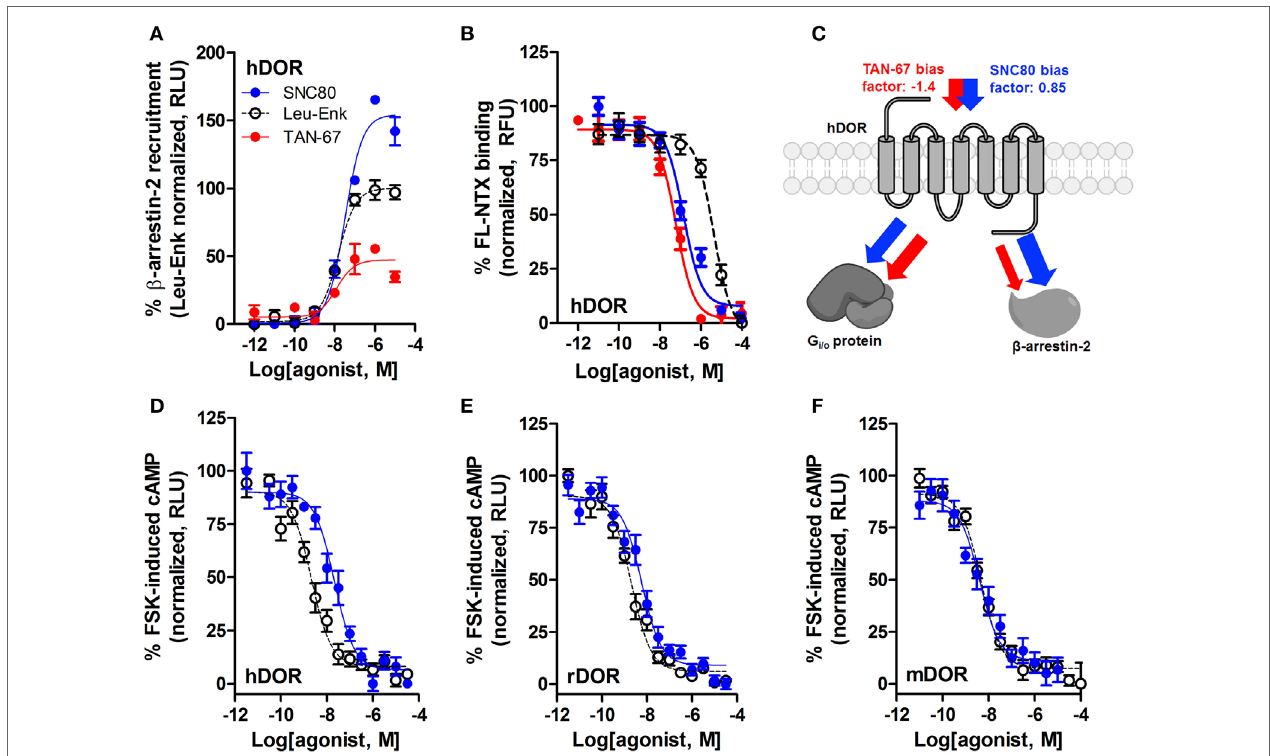
FigUre 3 | SNC80 is a β -arrestin-biased agonist with comparable potency across species in heterologous cell systems. At the hDOR, SNC80 acts as a β -arrestin-2 super-agonist compared with the endogenous agonist leu-enkephalin and the weak β -arrestin-2 recruiter TAN-67 (a) . SNC80 and TAN-67 bind to hDOR with similar affinity (B) . Schematic representation of the observed ligand bias of TAN-67 and SNC80 at hDOR, with calculated bias factor (c) . SNC80 and Leu-enkephalin have similar potency to inhibit forskolin-induced cAMP production at hDOR (D) , rDOR (e) , and mDOR (F) . A representative summation is shown ( n ≥